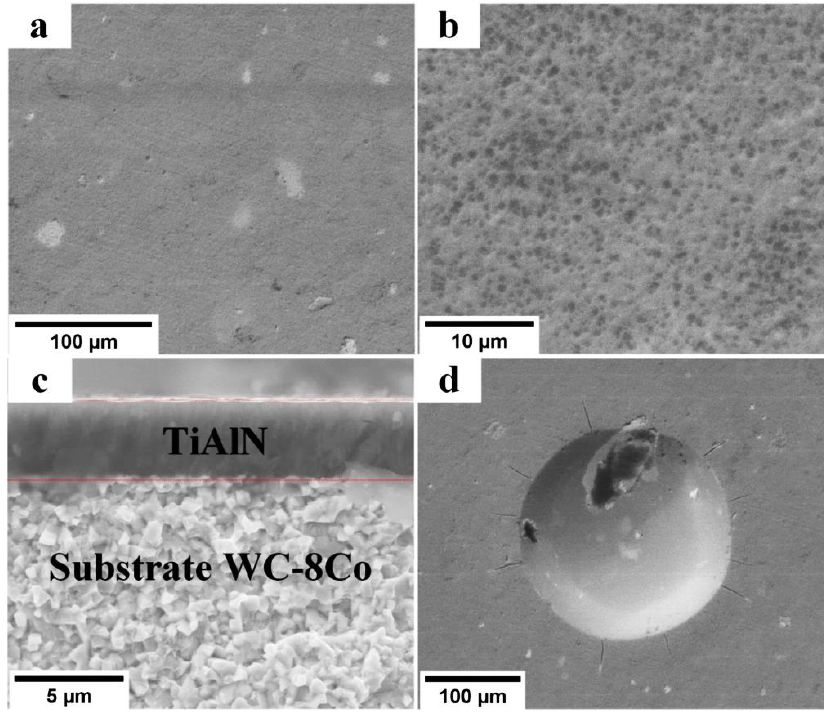
Figure 9. SEM images of the dual-HiPIMS-deposited Ti 0.61 Al 0.39 N coating: ( a , b ) surface, ( c ) cross-section, and ( d ) indentation crater formed after adhesion testing.